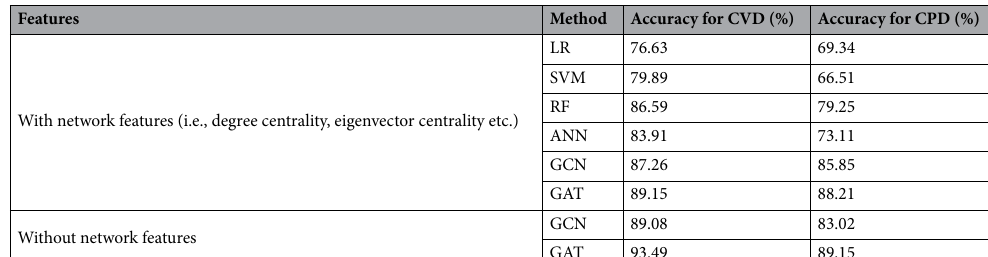
Features Method Accuracy for CVD (%) Accuracy for CPD (%)